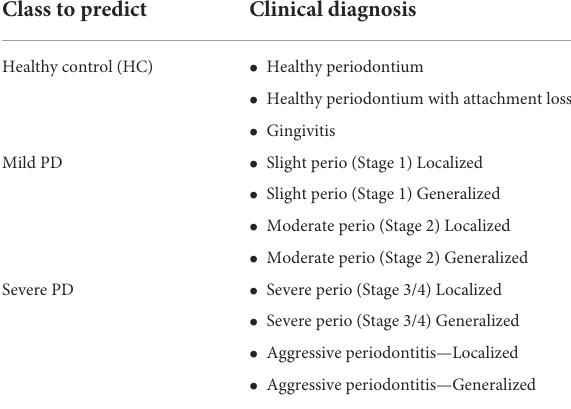
TABLE 2 Class label